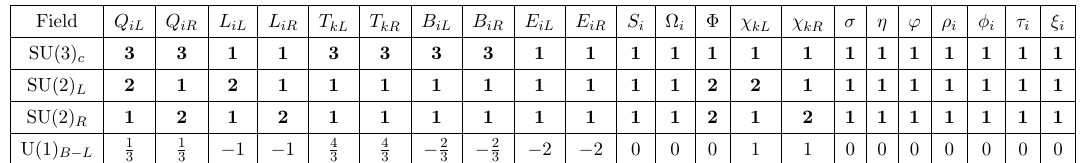
Table 1 . Particle content and transformation properties under the SU(3) U(1) B (cid:0) L gauge symmetries. Here i = 1 ; 2 ; 3 and k = 1 ; 2.